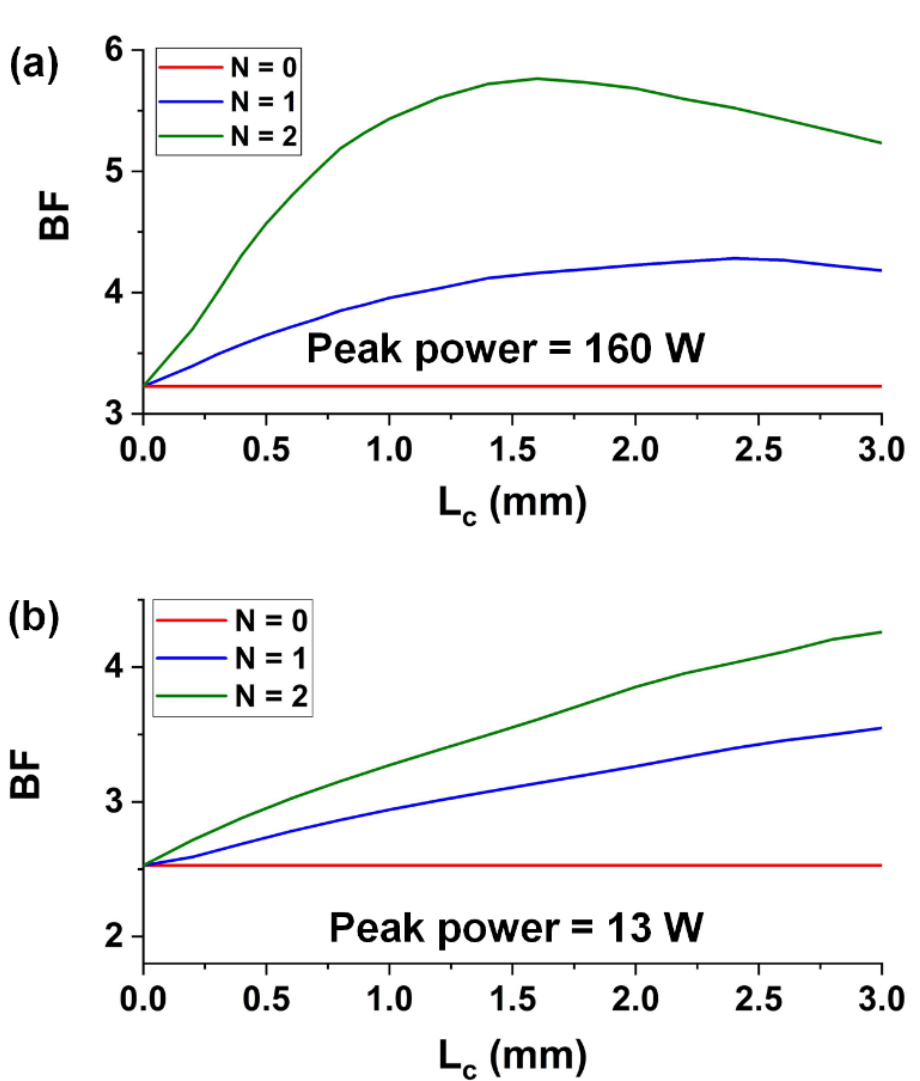
Figure 5. ( a ) BFs of femtosecond optical pulses versus GO film length ( L c ) for the hybrid waveguides with one and two layers of GO. The peak power is ~160 W. ( b ) BFs of picosecond optical pulses versus GO film length ( L c ) for the hybrid waveguides with one and two layers of GO. The peak power is ~13 W. In ( a , b ), the corresponding results for uncoated waveguides ( N = 0) are also shown for comparison.